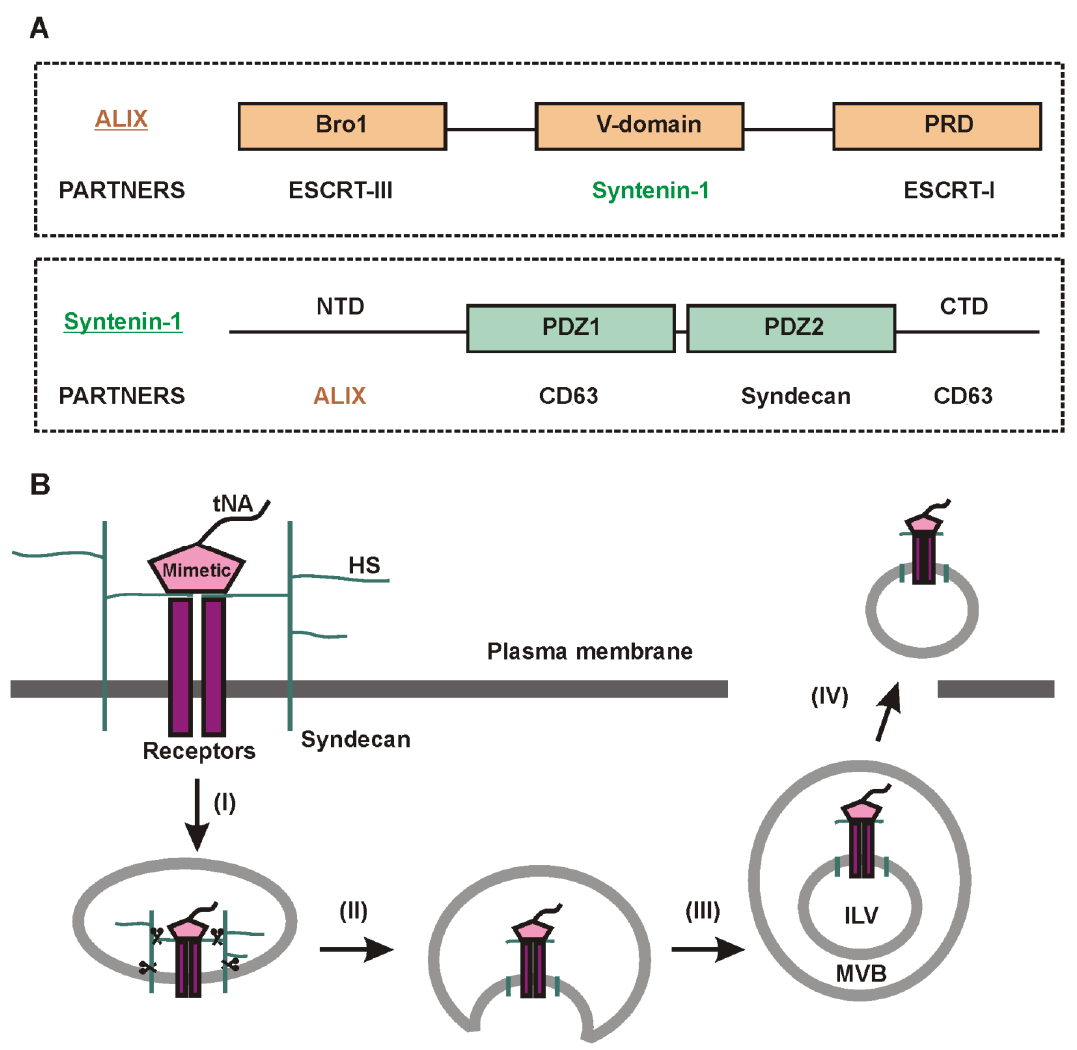
Figure 3. The ALIX–syntenin–syndecan pathway of exosome biogenesis. ( A ) Schematic illustration of the organization of ALIX and syntenin-1 protein domain structures [175,179] . ( B ) A proposed scheme for loading a tNA-conjugated ligand mimetic into exosomes. After endocytosis, syndecan is trimmered by heparanase in endosomes and subjected to proteolytic cleavage to its C-terminal fragment (I) [142,178,184] . The mimetic/receptor/HS complex can be sorted into ILVs in an ALIX- and syntenin-1- dependent manner (II–III; ALIX, syntenin-1, and ESCRTs not shown). The complex can be secreted into the extracellular environment via exosomes (IV). HS—heparan sulfate; PRD—proline-rich domain; NTD—N-terminal domain; CTD—C-terminal domain.